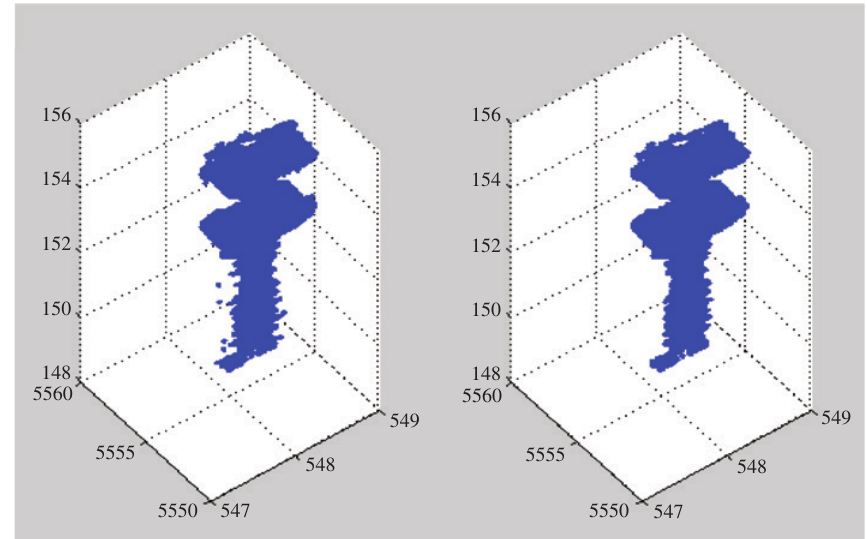
Figure 8: Comparison of Point Cloud Before and After Denoising.